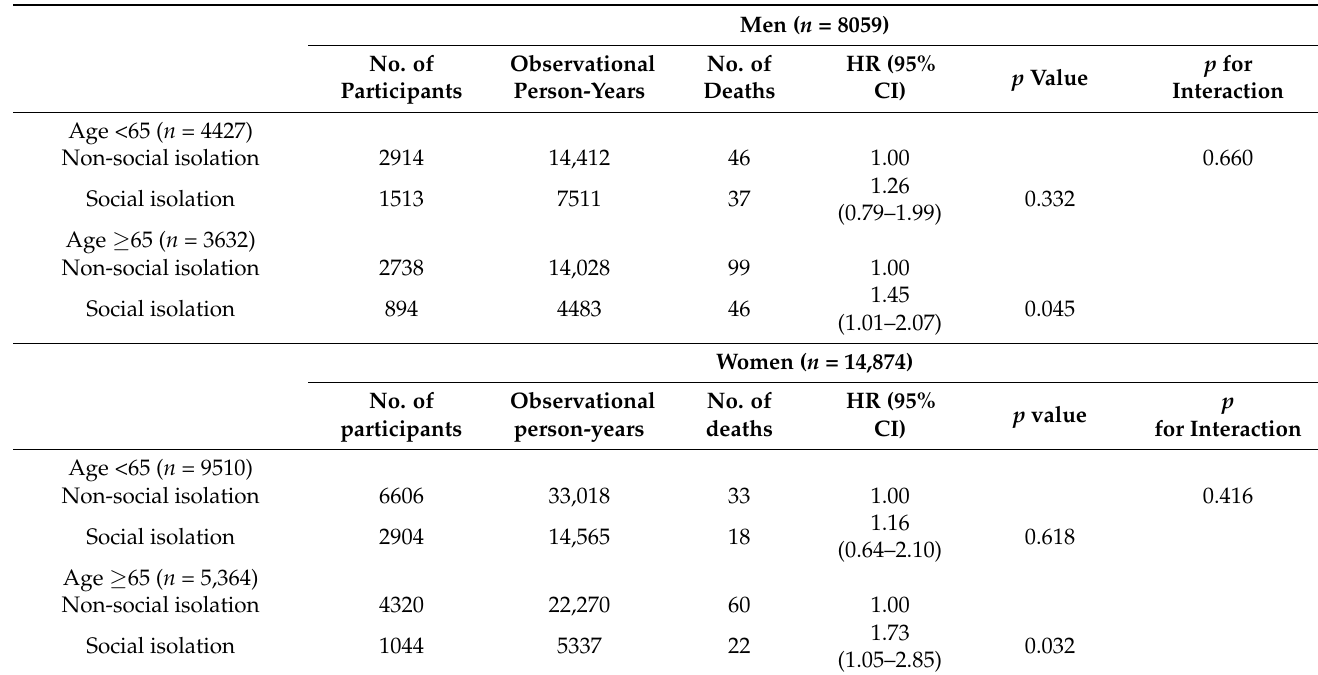
Table 3. Adjusted HRs (95% CIs) of total mortality according to social isolation by age